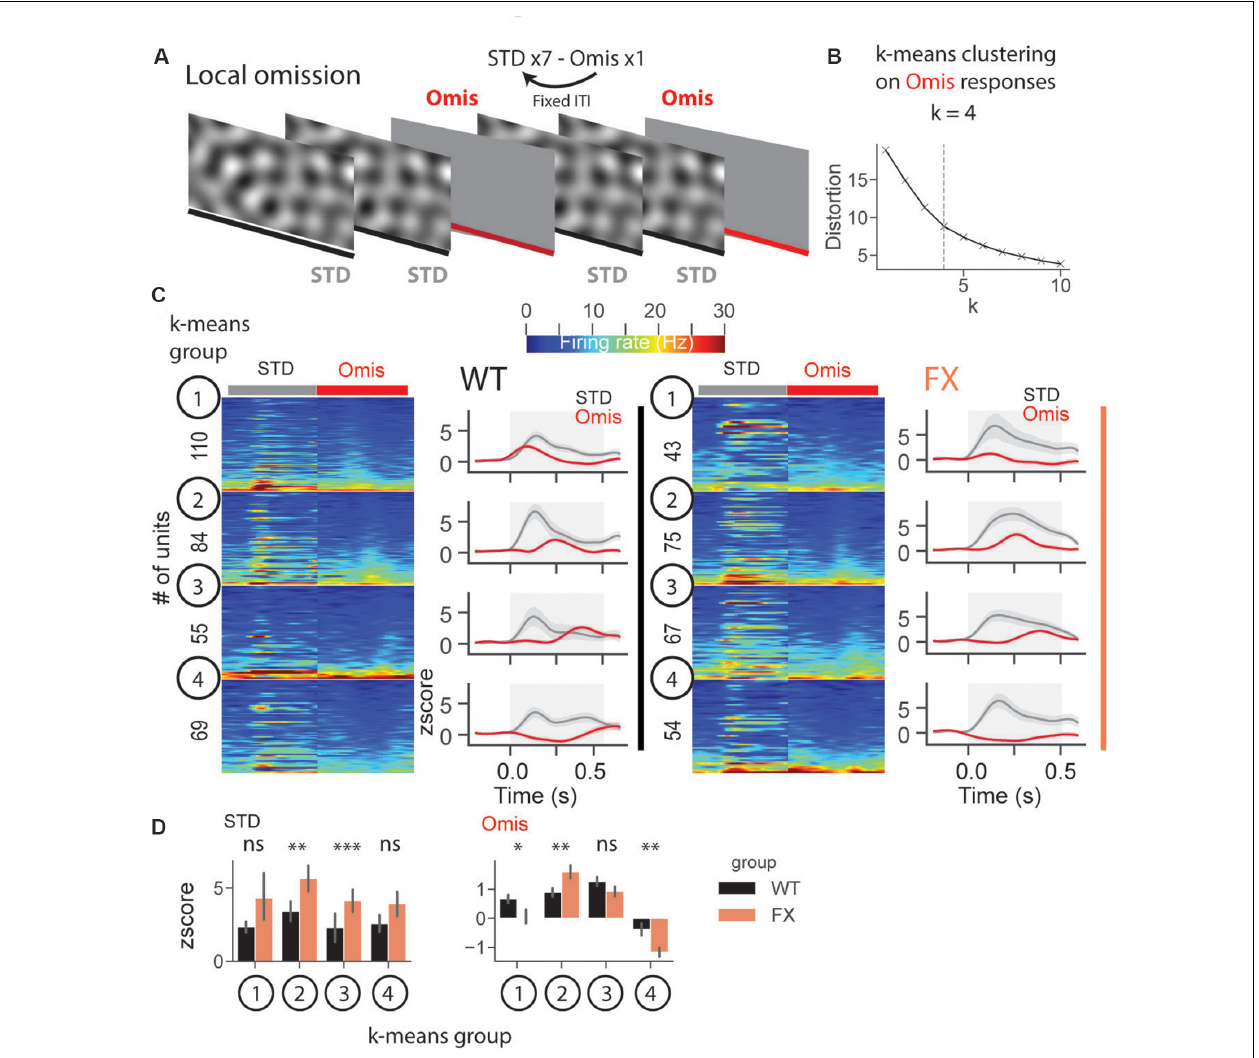
FIGURE 8 | Altered representation of omission responses in FX mice. (A) During the omission paradigm every eighth stimulus was not presented (omission). (B) The number of groups for k -means was determined using the elbow method. Clustering was performed on omission responses (0.05–0.5 s) from units of both genotypes. Given that genotype is independent of clustering, we compared neural responses between WT and FX within each k -means group. (C) The heatmaps of unit firing rate responses across different k -means groups and genotypes (left = STD, right = Omis). The line plots show the mean z score firing rate responses of units shown in the heatmaps. 1st k -means group shows early, 2nd group mid, and 3rd group late omission responses, and 4th group was inhibited by Omis. (D) The point plots show the mean ± SEM z score firing rate for STD (left) and Omis (right) responses for WT and FX. ∗ p < 0.05, ∗∗ p < 0.01, ∗∗∗ p < 0.001, ns = not significant.